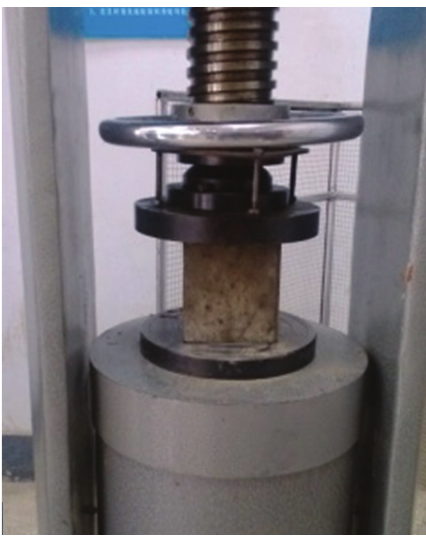
Figure 4: Compression test.